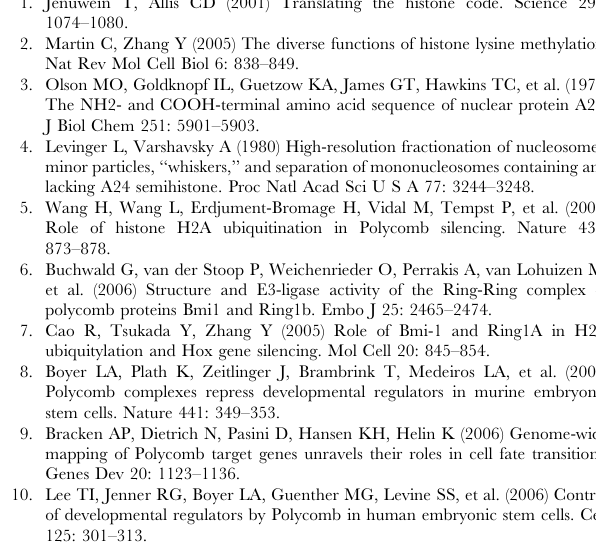
Table S4 List of primers used in this